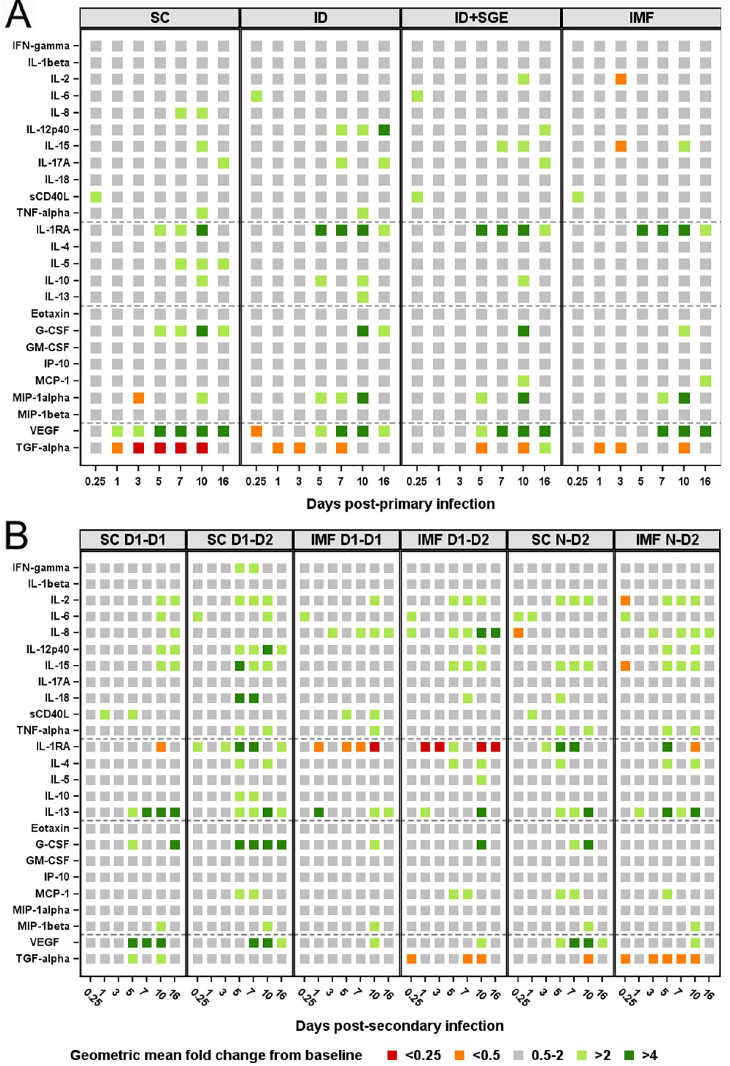
Fig 4. Cytokine protein detection in peripheral blood following primary and secondary DENV exposures. Serum was collected at 0 hour, 6 hours, and days 1, 3, 5, 7, 10, and 16 post A) primary DENV-1 infection and B) homologous DENV-1 re-exposure, heterologous DENV-2 infection, and primary DENV-2 infection. Twenty-five cytokines, chemokines, and growth factors in serum were assessed. Data are expressed as geometric mean fold change ranges relative to baseline (0h). Fold change values within 2-fold of baseline were considered unchanged from baseline. n = 10 for each SC, ID+SGE, and IMF; n = 9 for ID; n = 5 for the remainder of groups. SC, subcutaneous; ID, intradermal; ID +SGE, intradermal + salivary gland extract; IMF, infectious mosquito feeding; D1-D1, homologous DENV-1; D1-D2, heterologous DENV-2; N-D2, primary DENV-2. the primary DENV-1 infection groups, serum RNAemia and viremia were measured and sta- tistical comparisons were made for peak titer observed, AUC, day of onset, and duration. Interestingly, as shown in Fig 6, the IMF N-D2 group did not differ significantly in RNAemia peak, AUC, onset, or duration as compared to SC N-D2, yet did demonstrate a significantly higher viremia peak titer (4.17-fold) and AUC (2.44-fold). The discrepancies in the IMF and SC observations between primary DENV-1 and DENV-2 infections suggest a serotype- or strain-specific relationship with the infection modality, possibly through differences in verte- brate or vector infectivity or through differences in interactions with specific MSP. Serotype